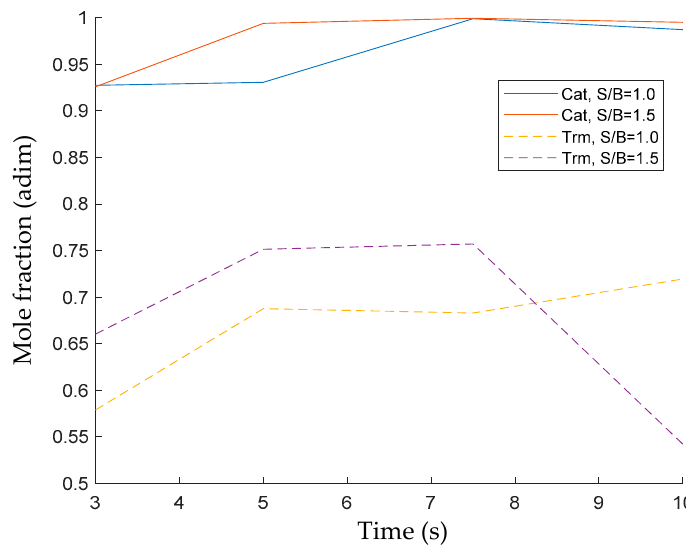
Figure 10. Thermal and catalytic conversion of 2M4MP at an S / B ratio of 1.0 (initial concentration of 0.388 g2M4MP / L) and 1.5 (initial concentration of 0.204 g2M4MP / L). Note: results reported are at the reaction temperature of 500 ◦ C. Standard deviations for repeats: 5–7.